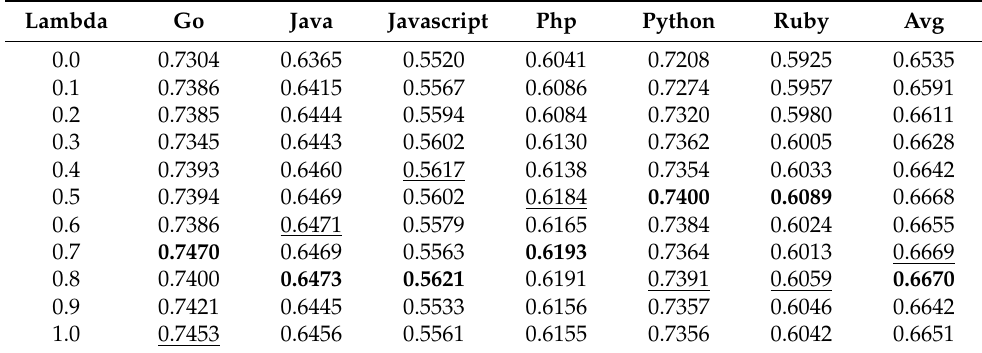
Table 4. The effect of λ on the student